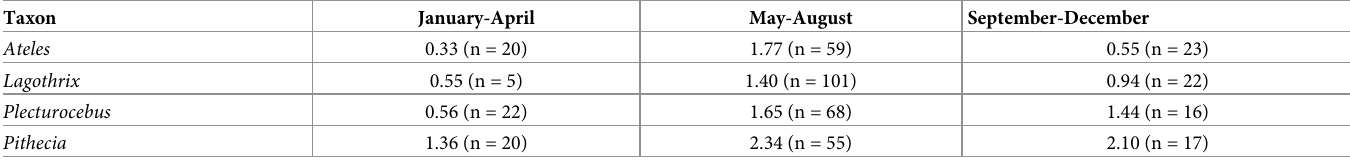
Table 7. Median times of first feeding bouts (hours relative to